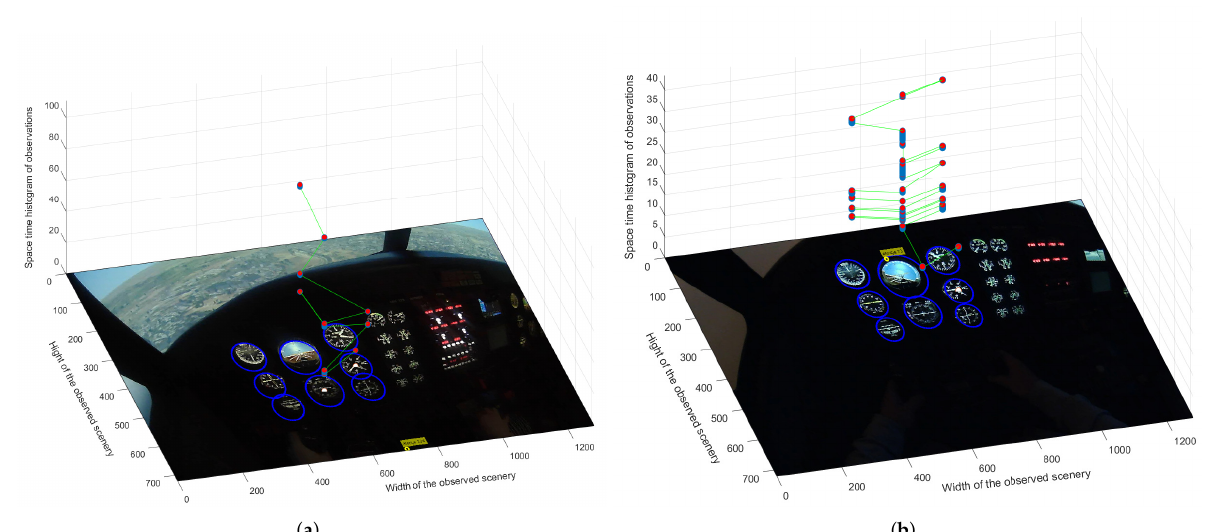
Figure 7. Spatio-temporal trajectory of the observer’s attention fixation for a GA class simulator for VFR ( a ) and IFR conditions ( b )